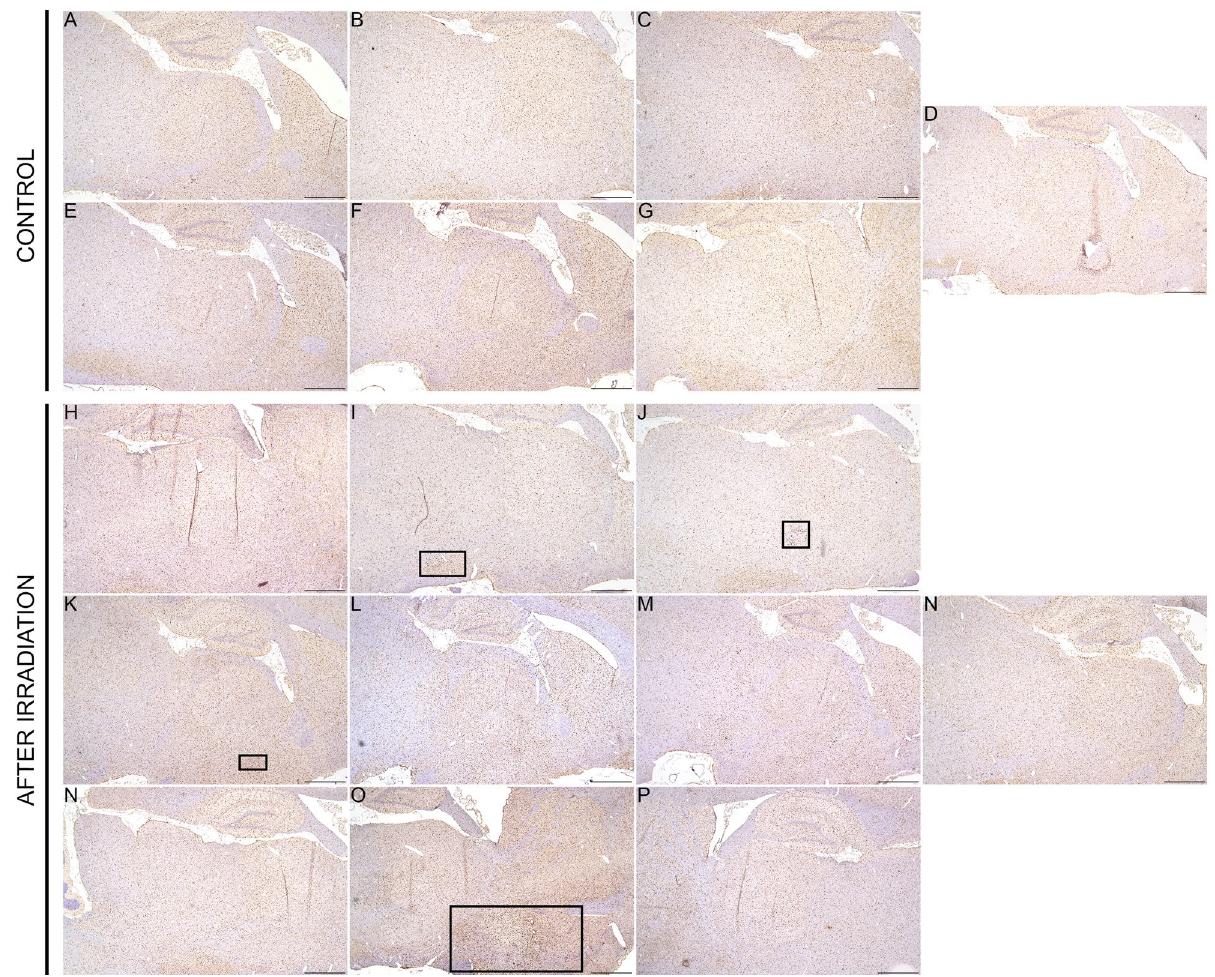
Figure 7. Low magnification (Iba1 immunohistochemistry) of sagittal brain sections (scale bar: 1 mm) of each rat showing small loci of reactive microglial cells in three animals (I, J, K), after irradiation (black squares). Only one rat (P) displayed more extensive/severe